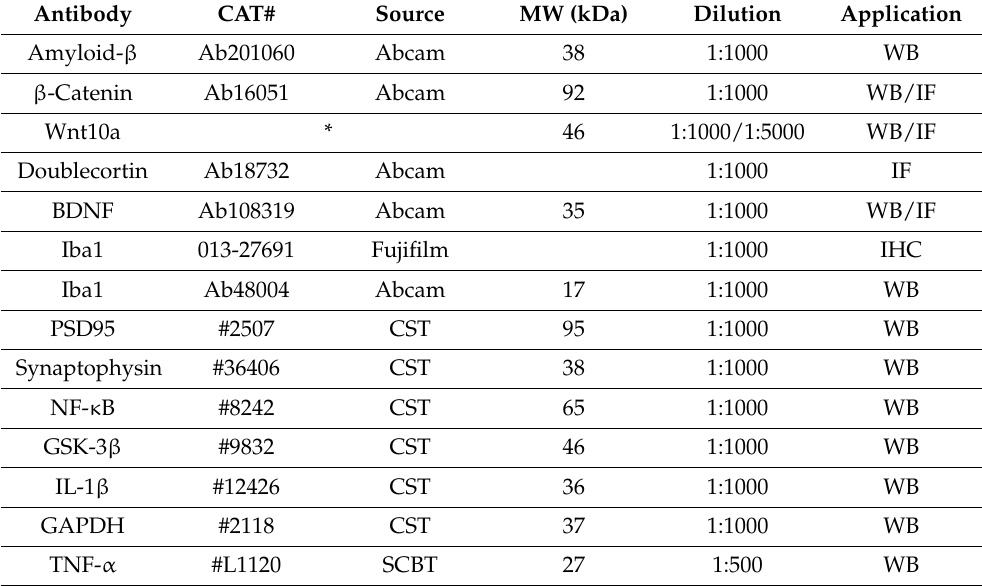
Table 1. Antibodies used in this